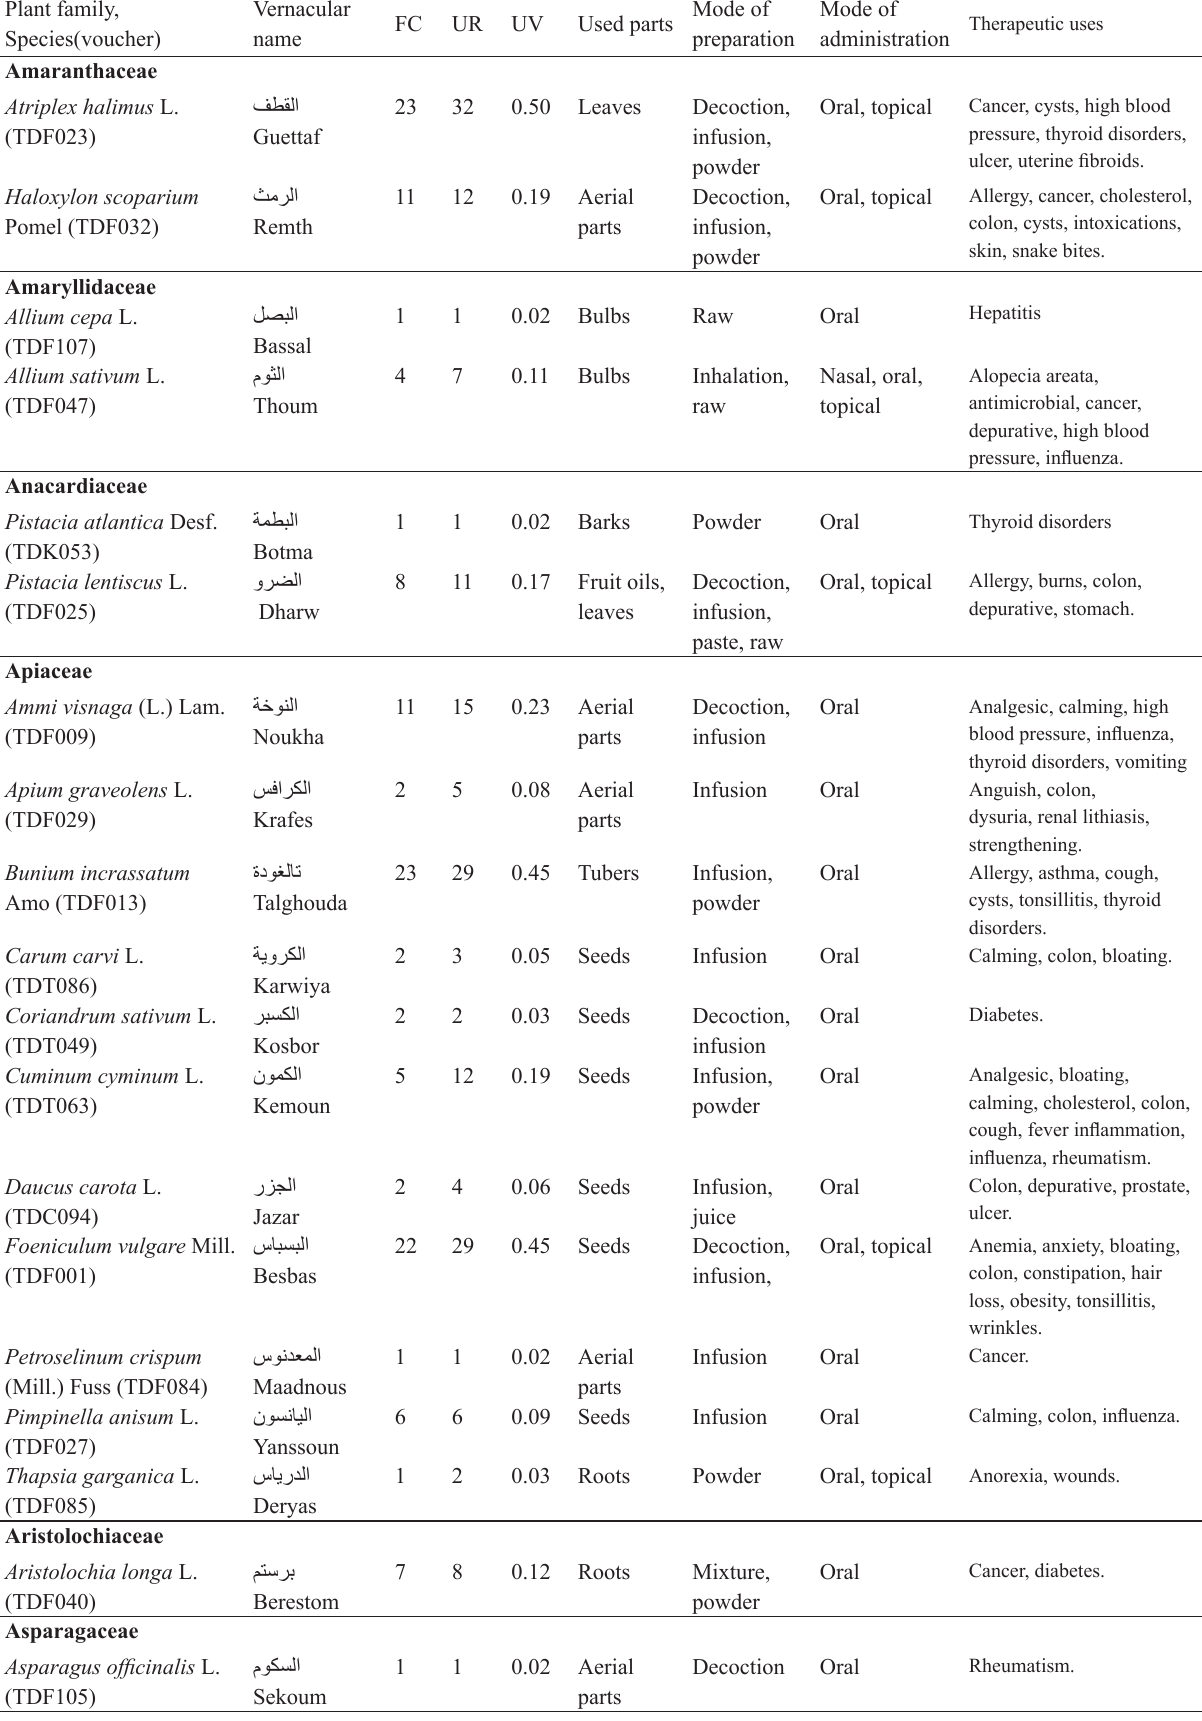
Table 2. Medicinal and aromatic plant species used in the region of Tiaret (north west of Algeria). Plant